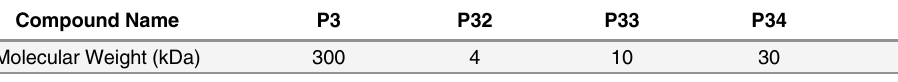
Table 1. Molecular weights of different λ